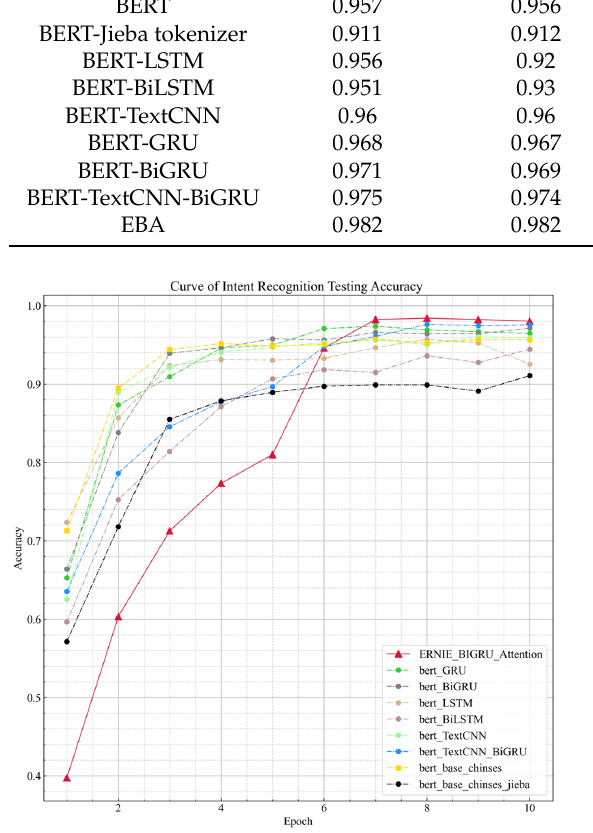
Figure 9. The accuracy curve of ATC instruction intention recognition on the test set.